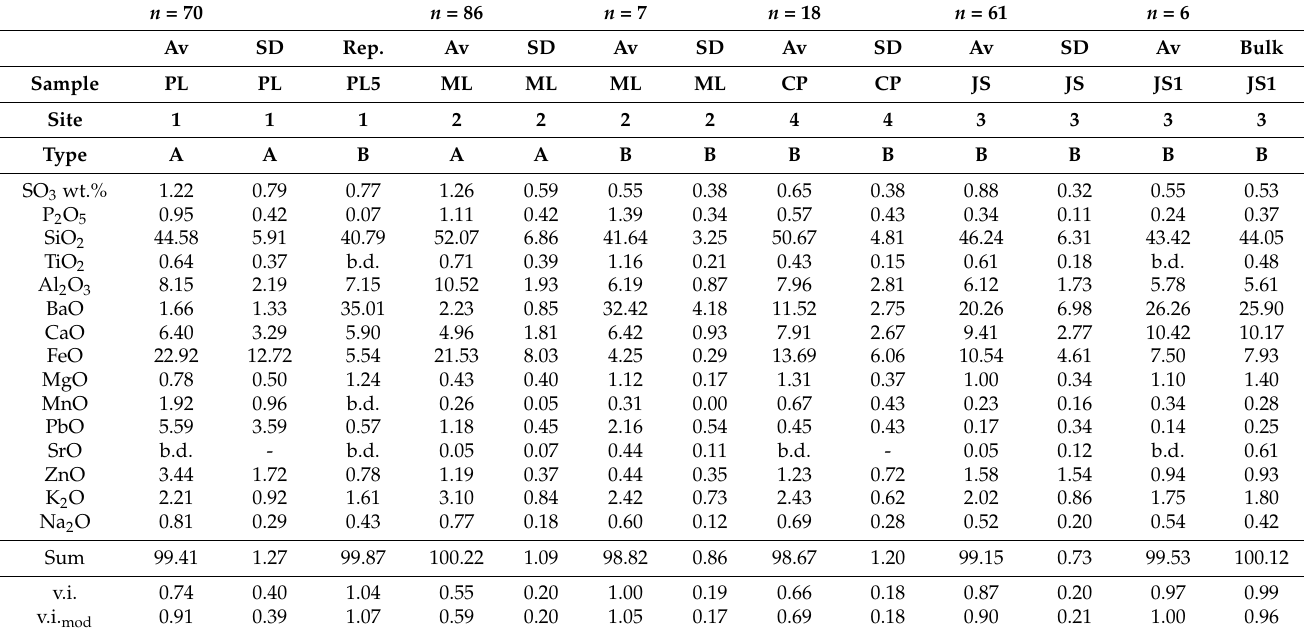
Table 5. Chemical composition of glass from JOD slags. Averages calculated from WDS and EDS. Av— average, SD—standard deviation, Rep.—representative analysis, bulk—bulk chemical composition, b.d.—below the limit of detection, - not